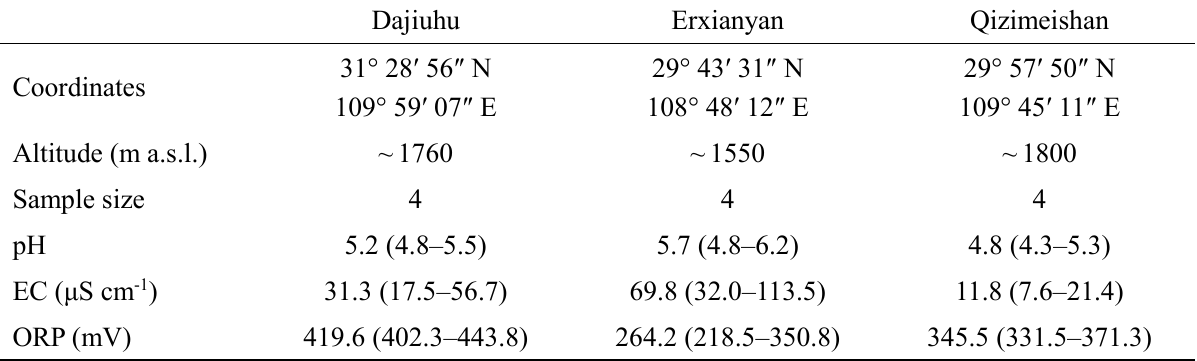
Table 1. Summary information on the Dajiuhu, Erxianyan and Qizimeishan peatlands. For the environmental factors pH, EC (electrical conductivity) and ORP (oxidation reduction potential), ranges are shown in brackets. Dajiuhu Erxianyan